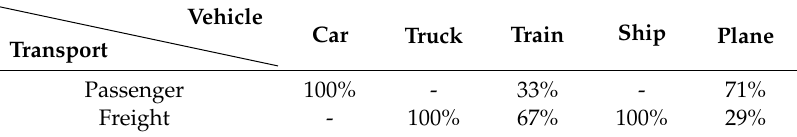
Table A7. The shares of flows from vehicles to transport services in China in 2015.